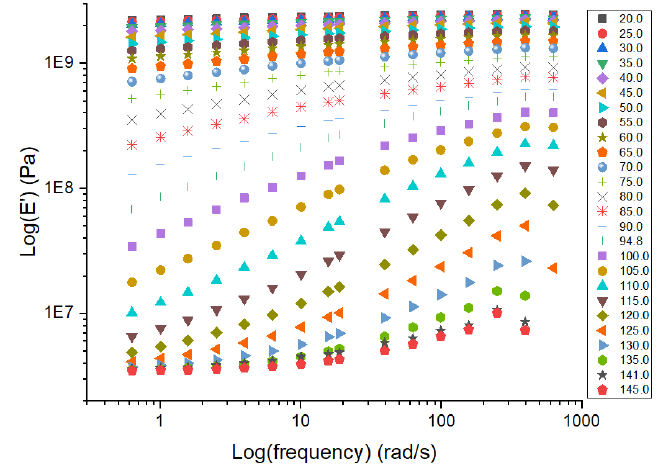
Figure 9. Storage modulus of Polymer D at various